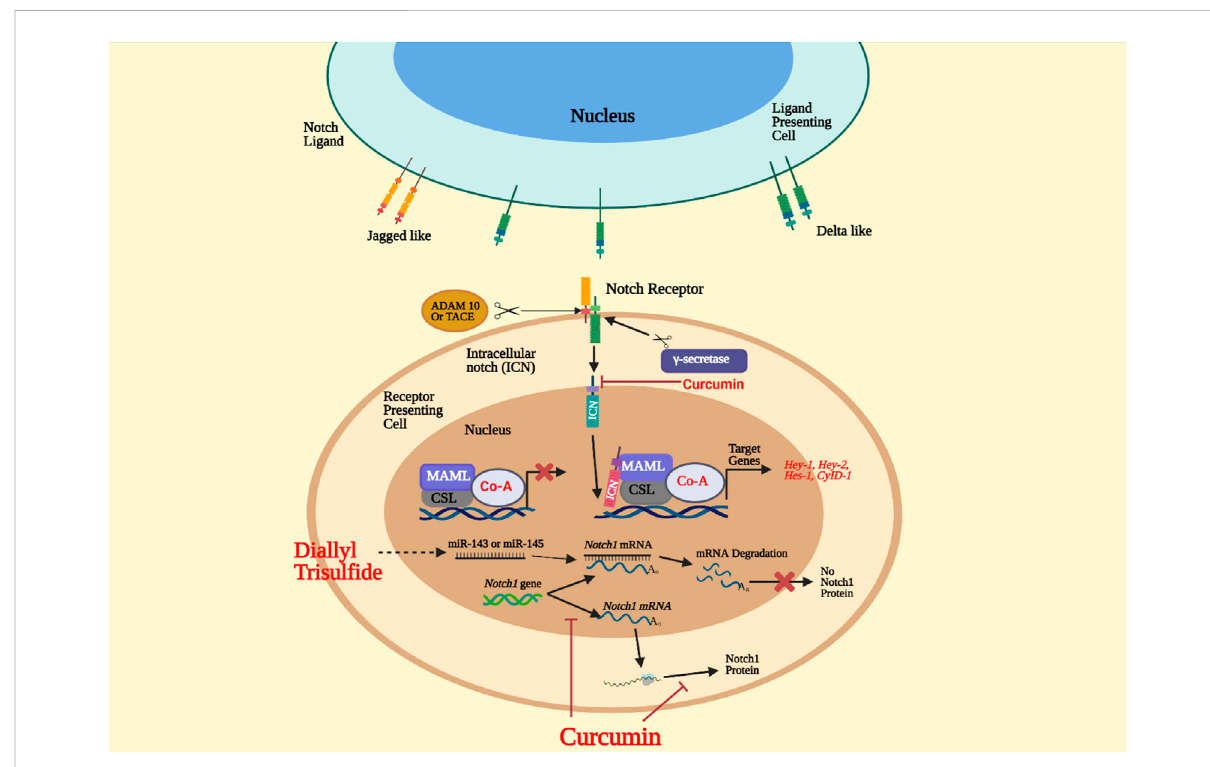
FIGURE 2 Notch signaling pathway. The ligand on the receiving cell connects the cell that acts as a presenter for the notch receptor. ADAM metalloprotease and γ -secretase split the Notch extracellular truncated (NEXT) domain, forming the notch intracellular domain (NICD). NICD is introduced into the nucleus and is a complex of transcription factors CSL 9 CBF1/hairless/lack 1 and transcriptional coactivator of mastermind-like proteins(MAML).Thecomplexwouldthenactivatethetargetgene ’ stranscription.Treatmentwithdiallyltrisul fi de(DATS)booststheexpression of tumor suppressor microRNAs miR-143 and miR-145. When microRNAs bind to Notch1 mRNA, the mRNA is degraded, but the Notch1 protein is not translated. Curcumin inhibits Notch1 transcription and expression and the nucleus ’ Hes-1, Hey-1, and Hey-2 genes (Angulo et al.,